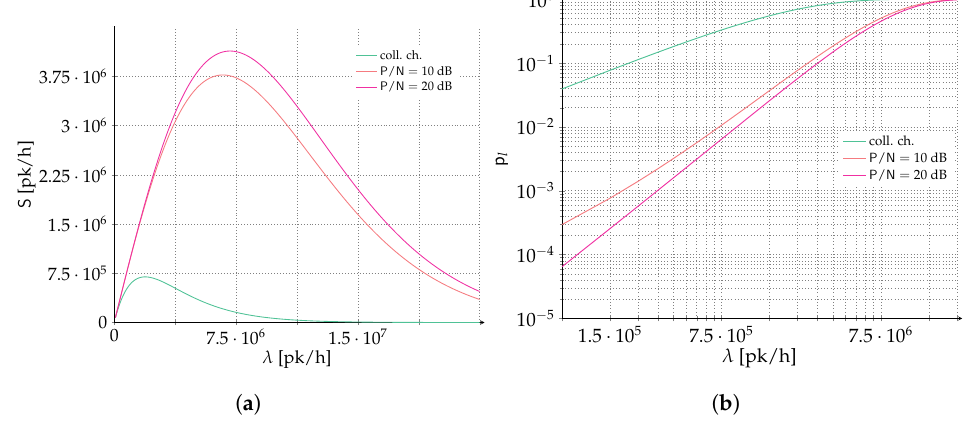
Figure 7. We consider a system similar to SigFox and we compare uncoded transmissions with data protected with forward error correction. We assume the return uplink of an LEO satellite communication system in the 860 MHz ISM band, with a satellite flying at 575 km, a maximum EIRP of 16 dBmW and a G/T of 22 dBi/K. An SNR between 18 and 22 dB could be achieve at the satellite for terminals at 40 ◦ − and 90 ◦ elevation angle respectively. Hence, to be conservative we present results for P / N = 10 dB and P / N = 20 dB and for the uncoded case. The transmission band is W = 100 Hz, and packets are sent asynchronous both in time and frequency. The total available band (channel bandwidth) is B = 200 kHz resulting in a B / W = 2000. The packet duration coincides with the maximum available payload of SigFox, i.e., 12 bytes or k = 96 bits. We compare this uncoded scenario with a system employing forward error correction with rate R = 1, emulating the possible choice of QPSK modulation coupled with a code rate 1/2 channel code. ( a ) Spectral efficiency. ( b ) Packet loss